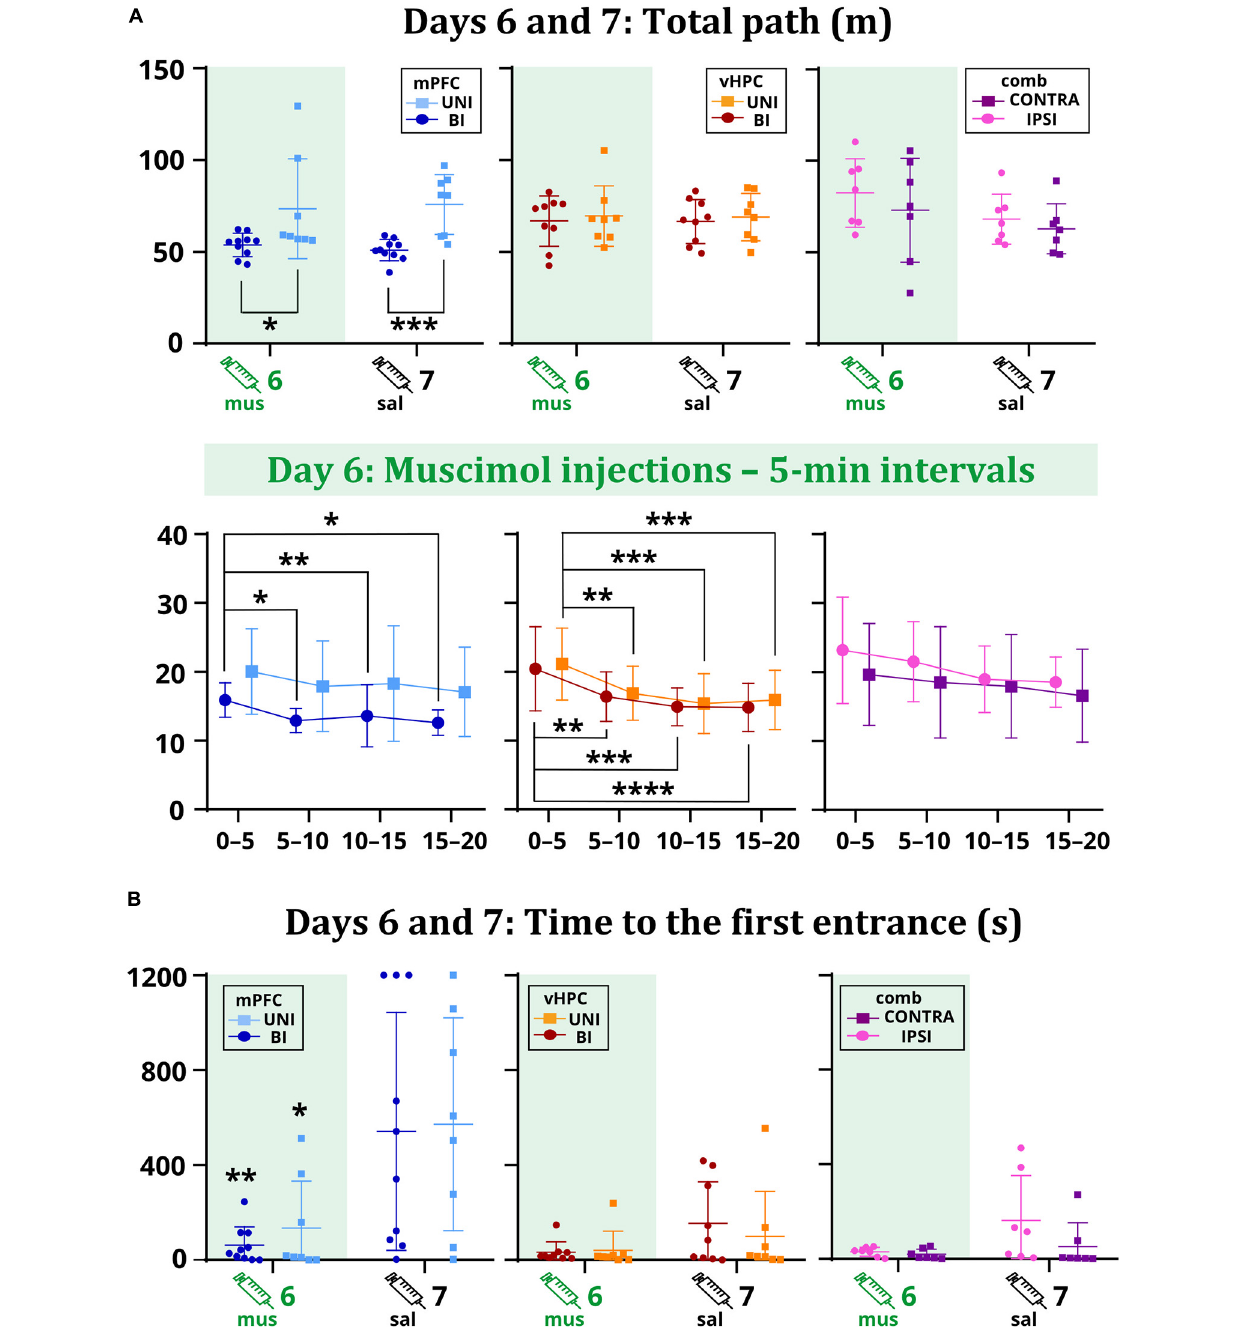
FIGURE 4 | The total path on days 6 and 7 (A) and the time to the first entrance on days 6 and 7 (B) . Muscimol had no effect on the total path, but differences were observed between the mPFC groups ( p = 0.0261 on day 6; p = 0.0006 on day 7). Analysis of the sixth day showed a tendency to move less for the BI/mPFC group ( p = 0.0371 between the intervals 0–5 vs. 5–10; p = 0.0029 vs. 10–15; p = 0.0126 vs. 15–20), but also for the UNI/vHPC (minutes 0–5: p = 0.0074 vs. 5–10; p = 0.0002 vs. 10–15; p = 0.0007 vs. 15–20) and BI/vHPC groups (minutes 0–5: p = 0.0067 vs. 5–10; p = 0.0001 vs. 10–15; p < 0.0001 vs. 15–20). No difference was observed in the combined groups. The first entrance occurred significantly earlier on day 6 than day 7 for the UNI/mPFC ( p = 0.0095) and BI/mPFC ( p = 0.0332) groups. * p < 0.05; ** p < 0.01; *** p < 0.001; **** p ≤ 0.0001.